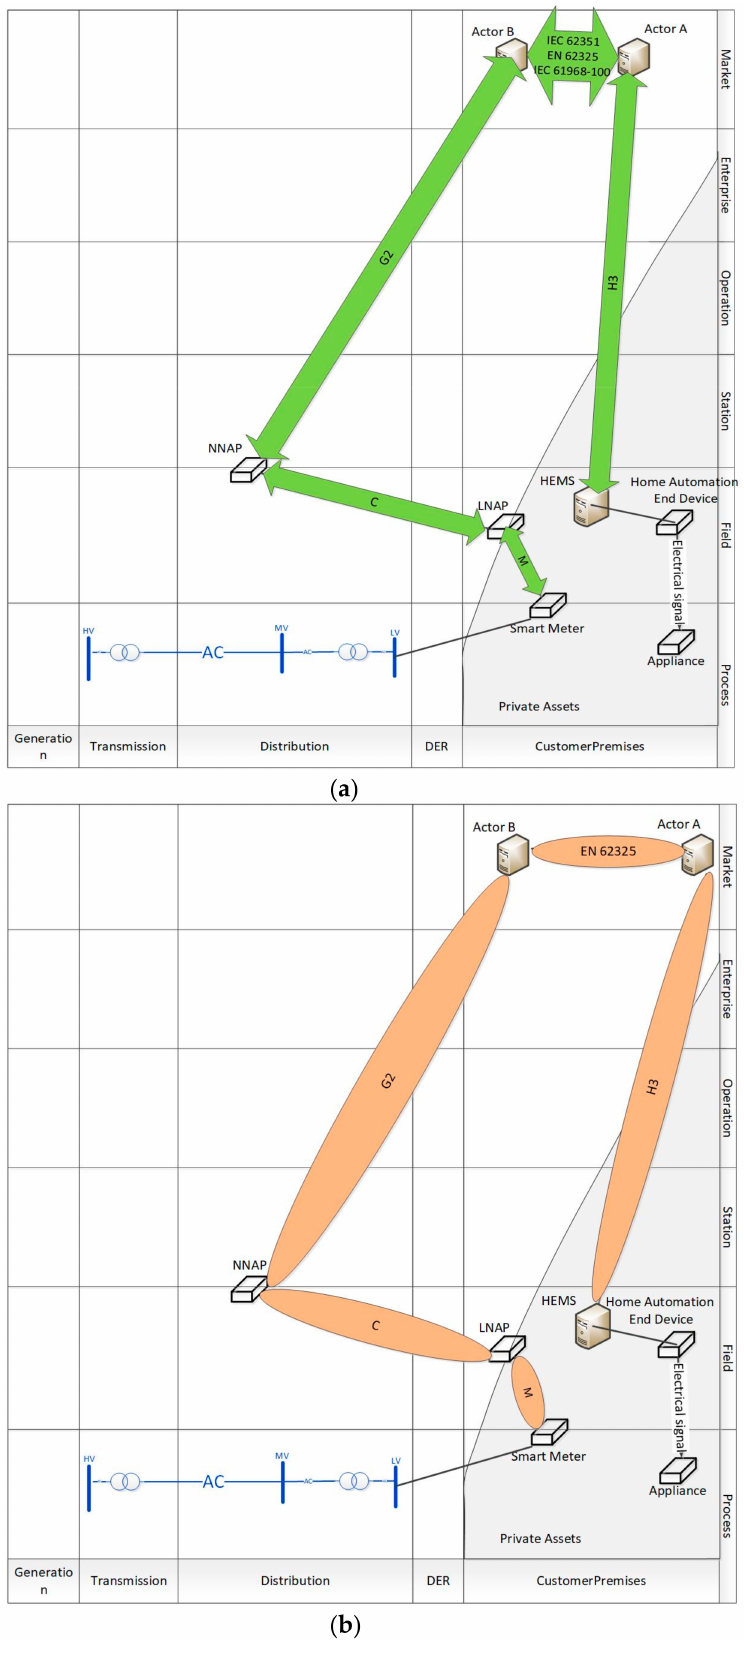
Figure 4. Representation of the use case on the SGAM ( a ) communication layer and ( b ) informa- tion